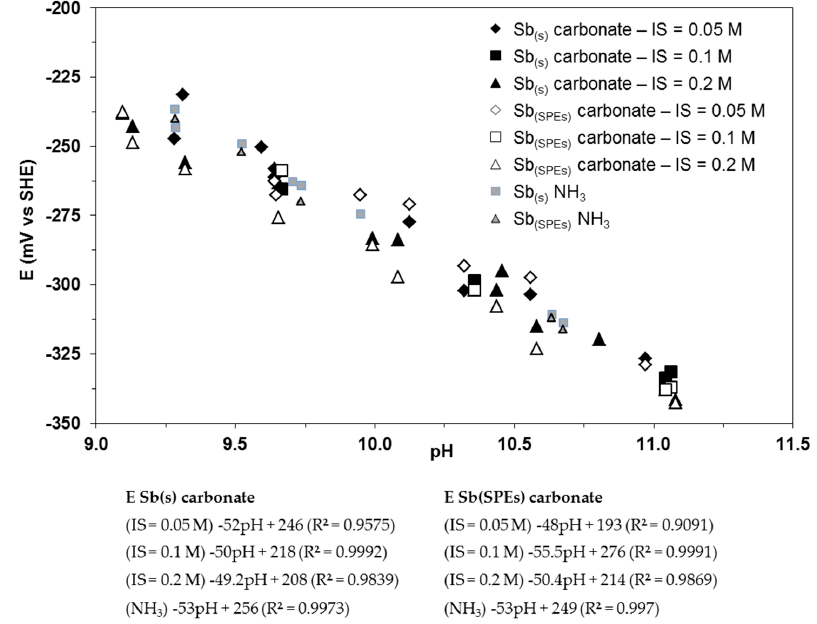
Figure 7. Eh-pH diagram of both Sb(s) and Sb(SPEs). Experiments were run in carbonate pH buffer solutions with various ionic strength (IS) and ammonia pH buffer solution under atmospheric pressure at 25